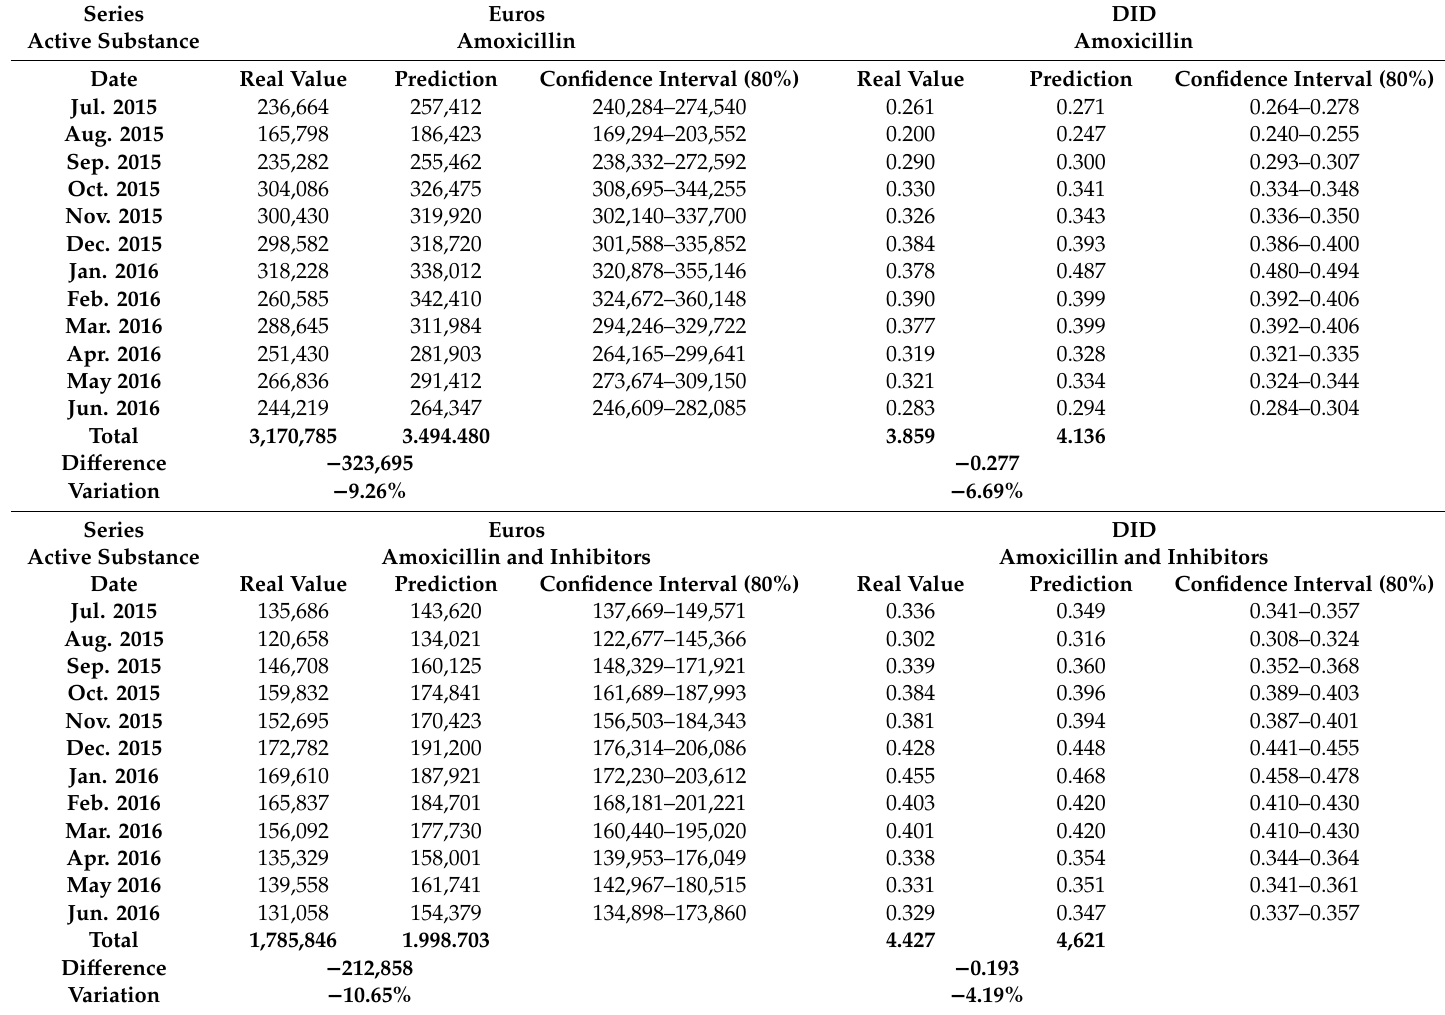
Table A6. Saving of the approval of the PRAN by active substance (predictions with the ARIMA models in Table